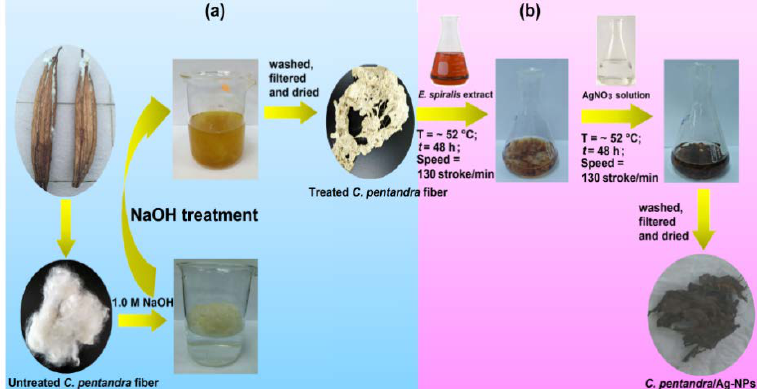
Figure 2. ( a ) Alkaline treatment of C. pentandra fiber and ( b ) in-situ biofabrication of Ag-NPs using E. spiralis extract and AgNO 3 solution steps of